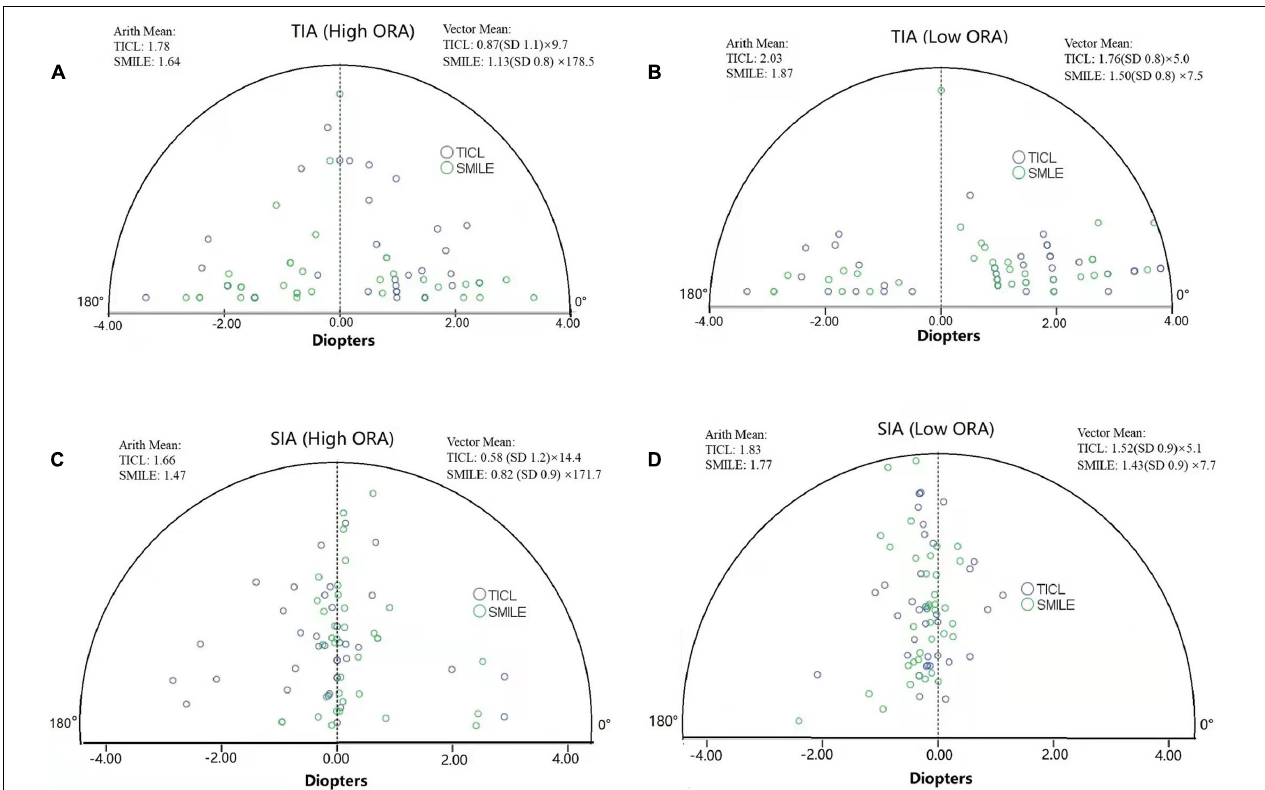
FIGURE 4 | Target-induced astigmatism vector (TIA, A,B ) and surgically induced astigmatism vector (SIA, C,D ) in high and low ORA groups on polar diagrams for toric implantable Collamer lens (TICL) implantation (Visian Implantable Collamer Lens; STAAR Surgical, Monrovia, CA, United States) and small incision lenticule extraction (SMILE) for the high and low ORA groups (Arith., arithmetic; ORA, ocular residual astigmatism).